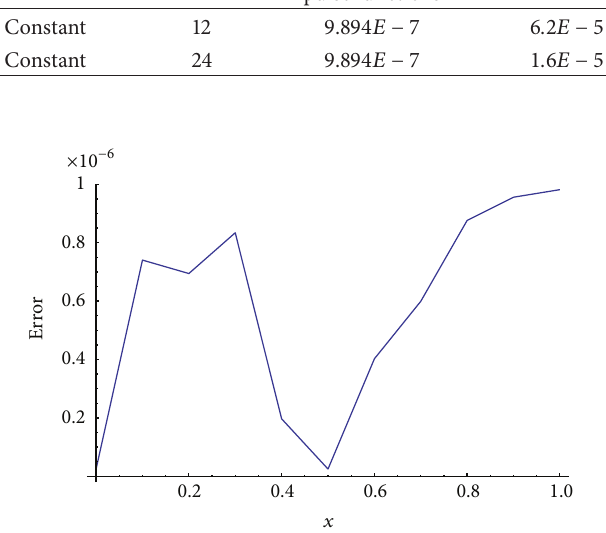
Figure 6: Max. absolute error plot (12 nodes), constant basis- Problem